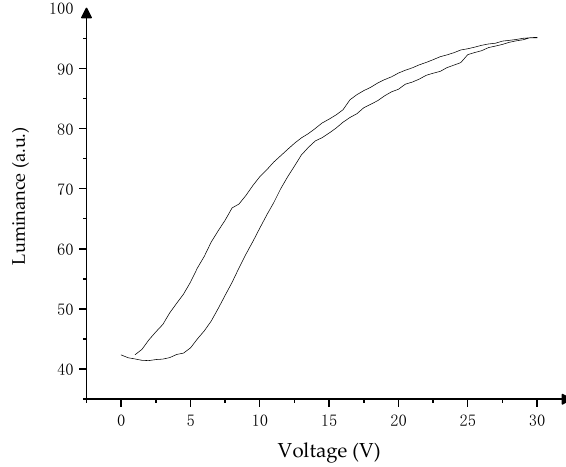
Figure 8. The hysteresis curve of an 8 inch TFT-EWD.